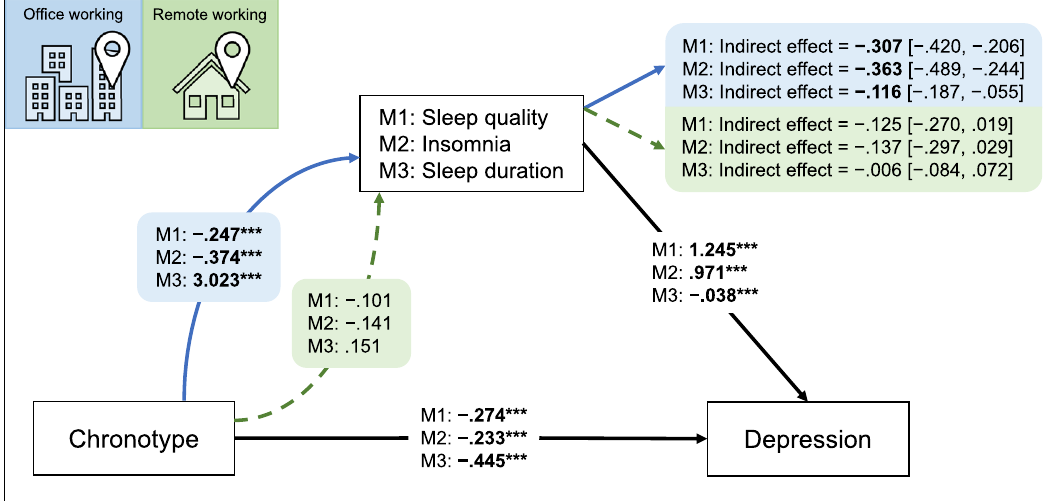
Figure 3. Summary of the results of the three moderated mediation models (M1, M2, M3). The figure reports the unstandardized coefficients of direct effects, conditional direct effects at the value of moderator, and conditional indirect effects with bootstrapped computed confidence intervals for the two levels of moderator [office working (blue arrow/area), remote working (green arrow/area)]. Significant effects are reported in bold, and the significance level of direct effects is indicated with asterisks (*** p <